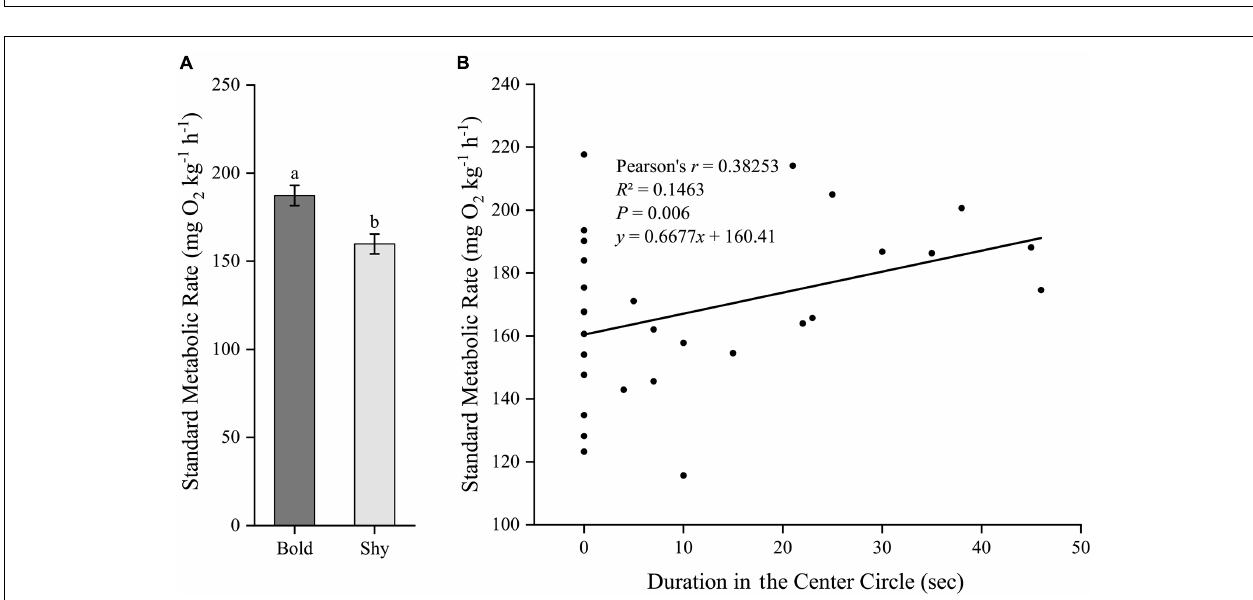
FIGURE 4 | The boldness and basal cortisol level of black rockfish. (A) The basal cortisol level in bold ( n = 9) and shy ( n = 44) groups. ( P > 0.05; independent samples t -test). (B) Pearson’s correlation between the latency to emerge from the start box (box-emerging boldness test) and the basal cortisol level ( n = 53).